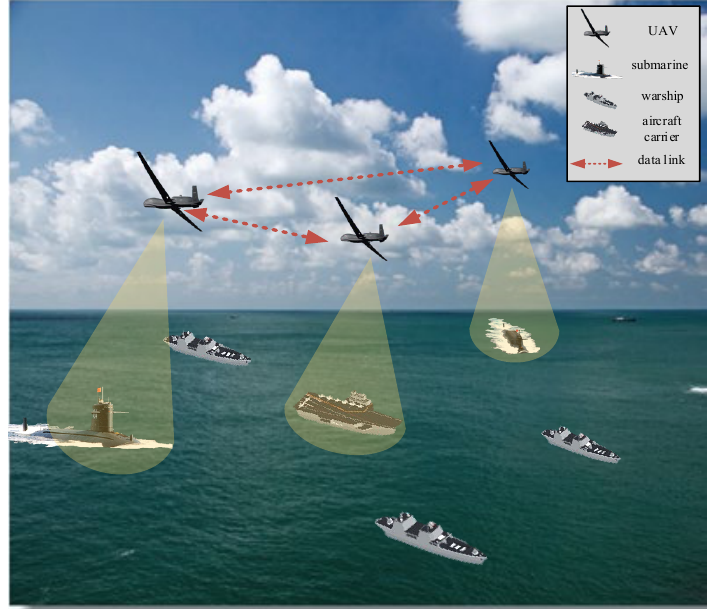
Figure 1. Multi-UAV cooperative search target scene.